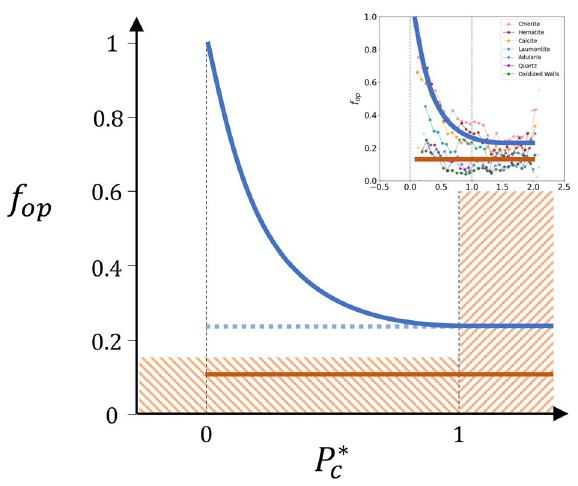
Figure 6. Schematic interpretation of the dependency of mineral fillings on fracture openness representing the openness as a function of the failure overpressure metrics P ∗ c . The shaded areas ( P ∗ c > 1 and f op < 0.15 ) indicate fractures that cannot be reactivated (see text). The red and blue solid lines are indicative of the two main trends observed, and the blue dashed line sketches the openness of the blue group’s fractures before reactivation. The box at the top right shows the original data and